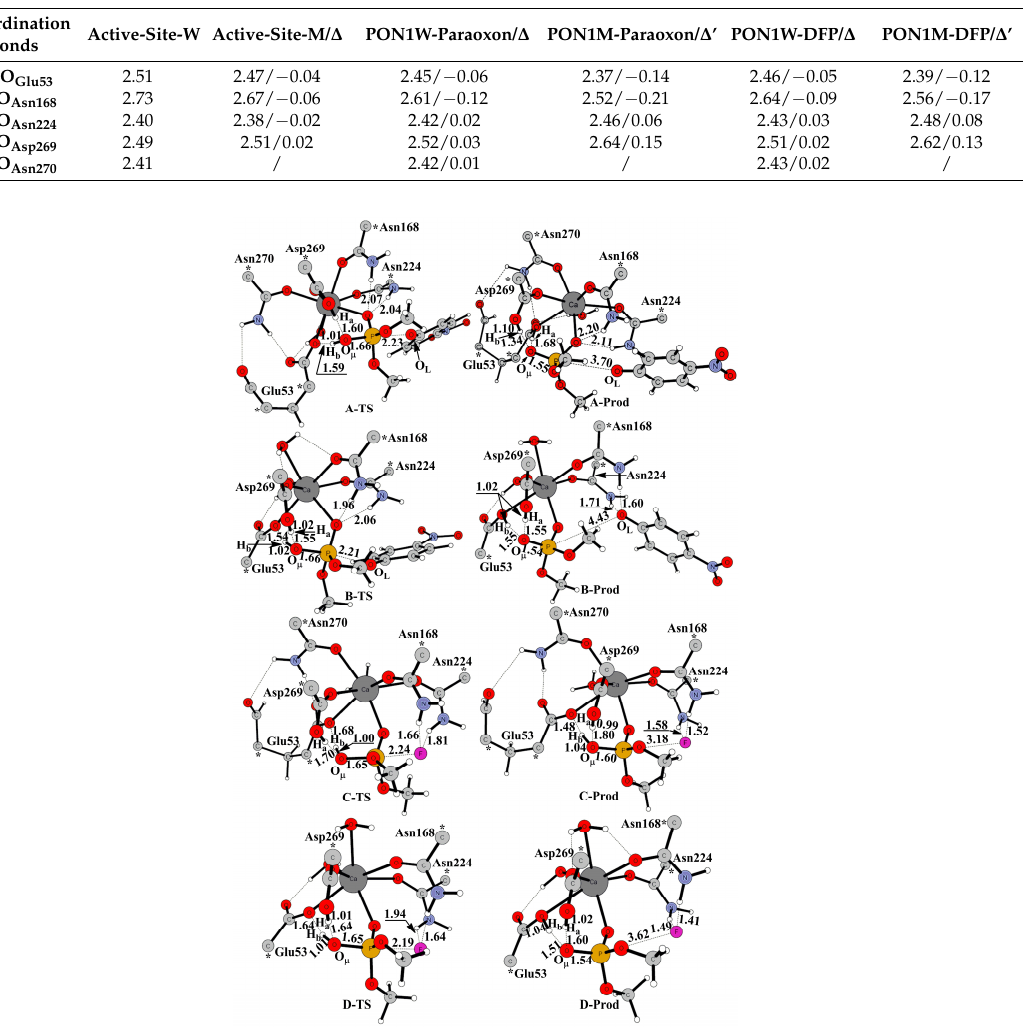
Figure 4. Optimized geometries of transition states and products along the reaction paths of ( A ) PON1W-Paraoxon, ( B ) PON1M-Paraoxon, ( C ) PON1W-DFP, and ( D ) PON1M-DFP models. The frozen atoms are marked with